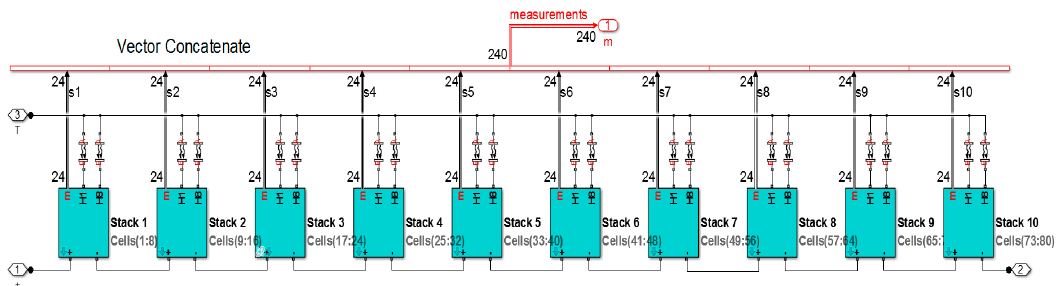
Figure 7. Ten stacks connected in series to compose a pack.